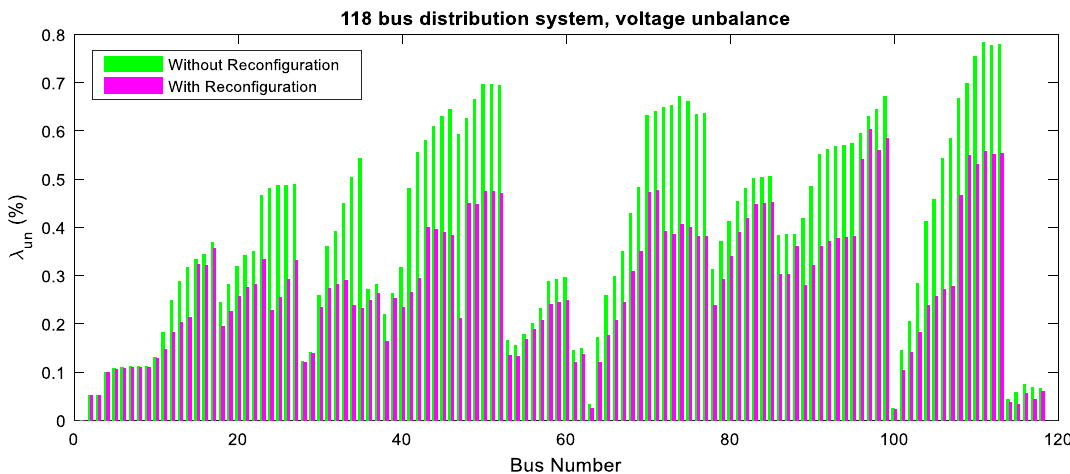
Figure 12. Voltage unbalance of 118-bus network via ITSOA with and without optimal configuration.